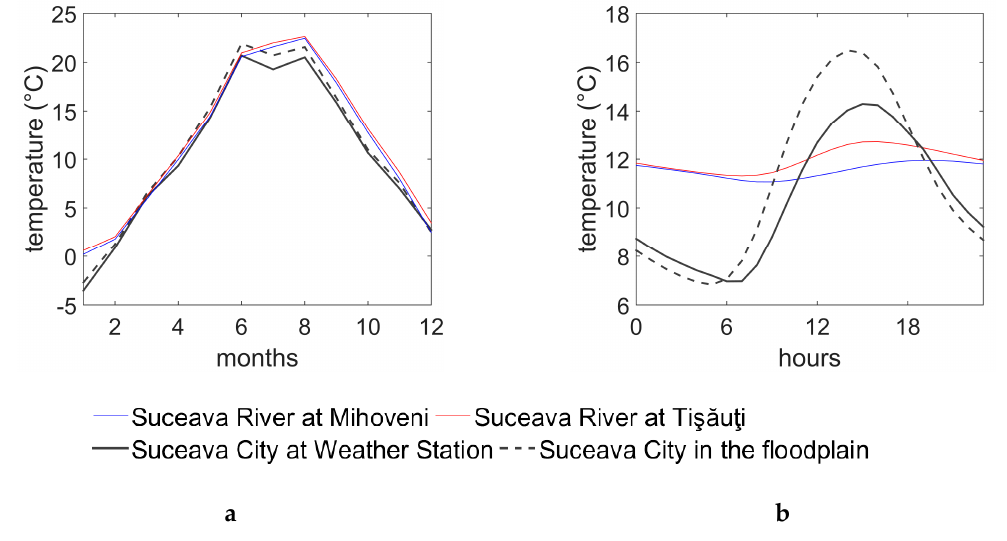
Figure 5. Comparisons of water and air temperatures in the Suceava city area in 2019: ( a ) annual regime of temperature, ( b ) average diurnal profiles.